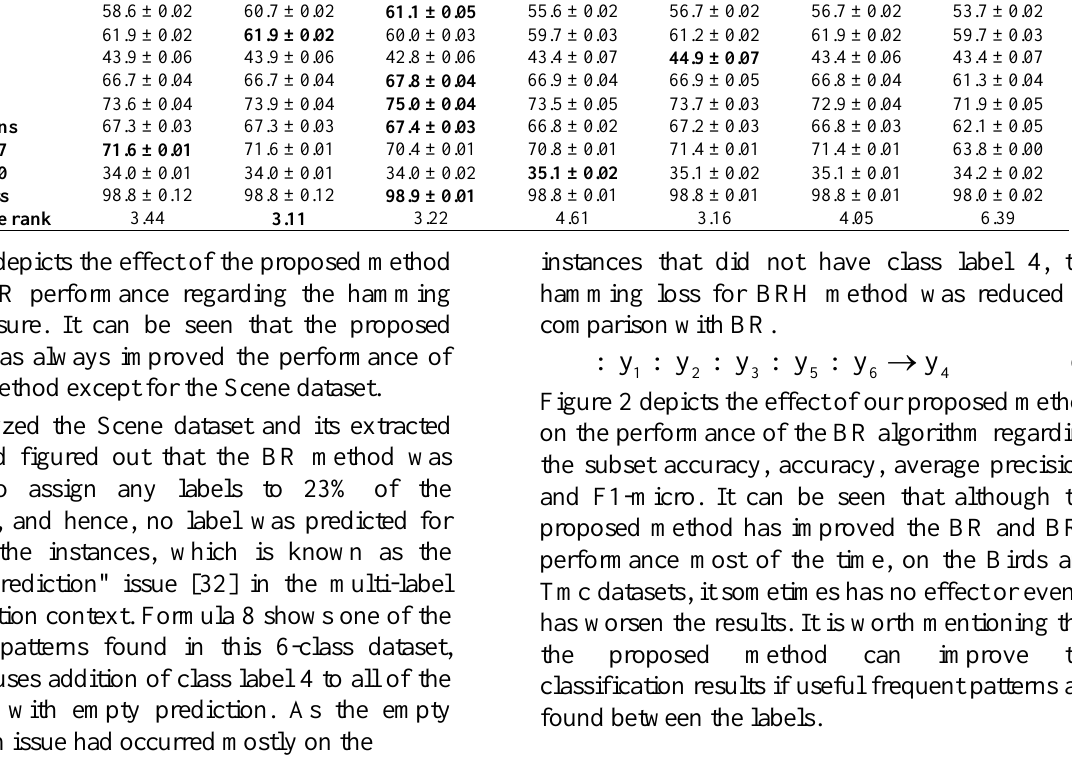
Table 6. Average and standard deviation of F1-micro of rival algorithms. Best results are shown boldface. Dataset BR BRP BRH